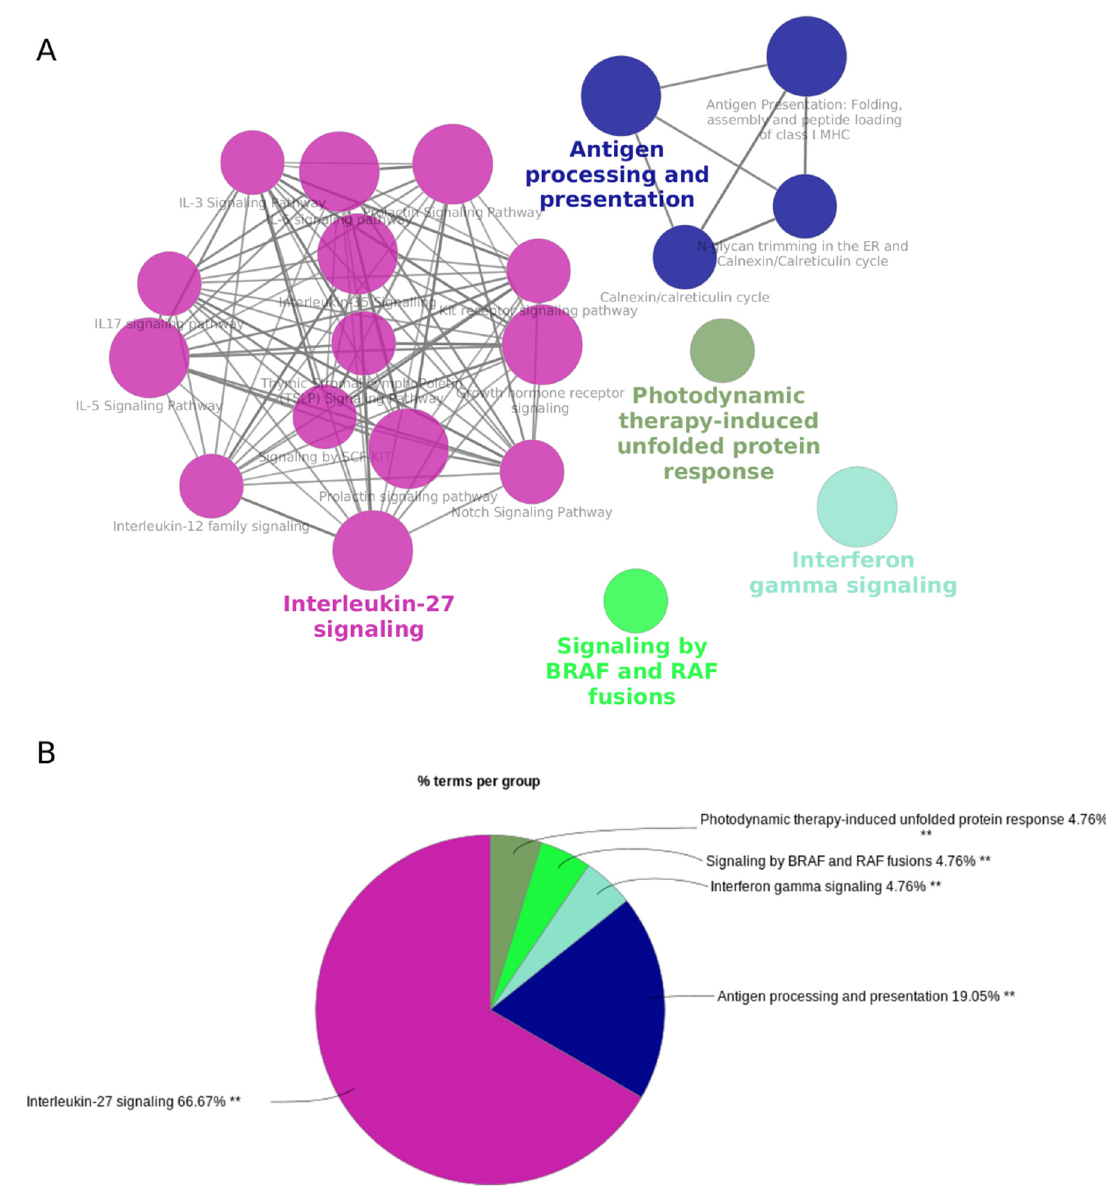
Figure 4. Network and pathway analysis of the DE circRNA host genes. ( A ) Network analysis based on pathway-based annotation of the 50 host genes of the DE circRNAs resulted in 21 significant pathways clustered into five groups. One selected term for each group is highlighted in bold. ( B ) Pie-chart representation of the above network highlights the five clusters (in different colors). The percentages shown for each cluster highlight their total contributions to the network based on the number of individual enriched pathway terms in each cluster. ** p < 0.01.